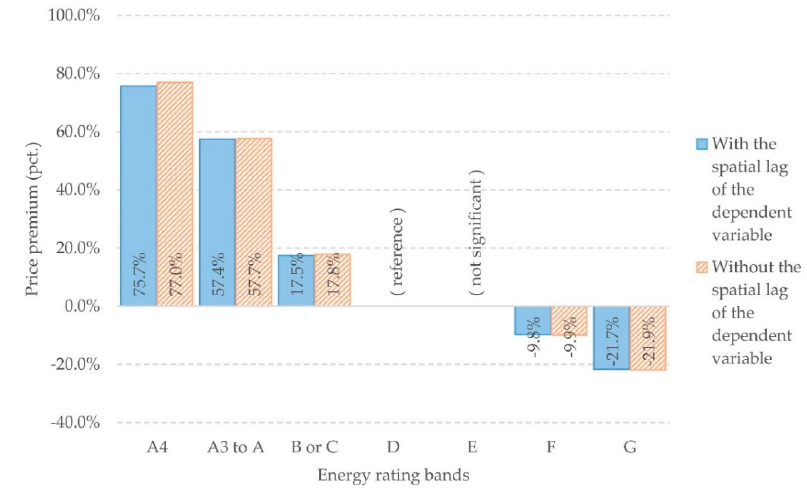
Figure 6. Estimated price premiums for the energy rating bands compared to the D label.